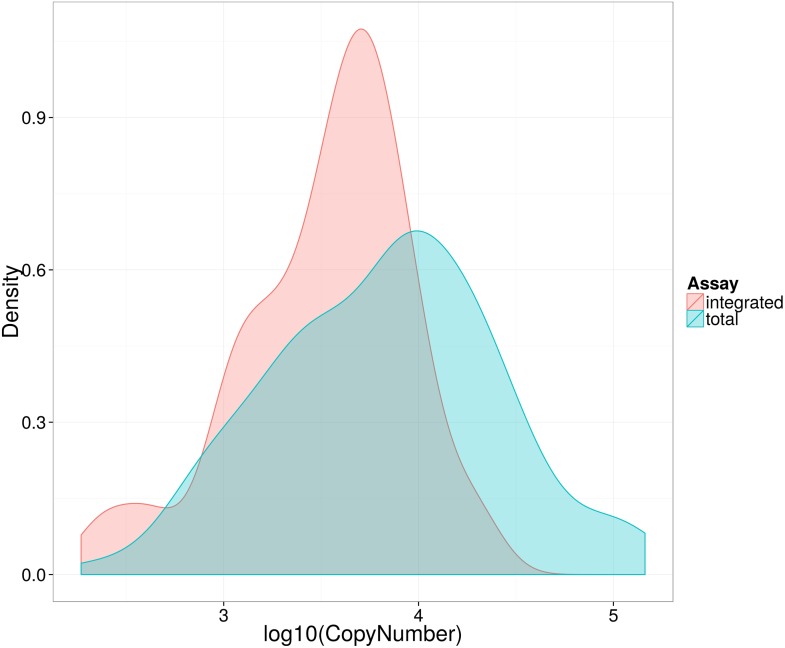
Distribution of log10 total and integrated HIV-1-DNA levels in untreated patients at baseline.Kernel density plot to show distribution of Total (blue) and Integrated (red) HIV-1-DNA at baseline.